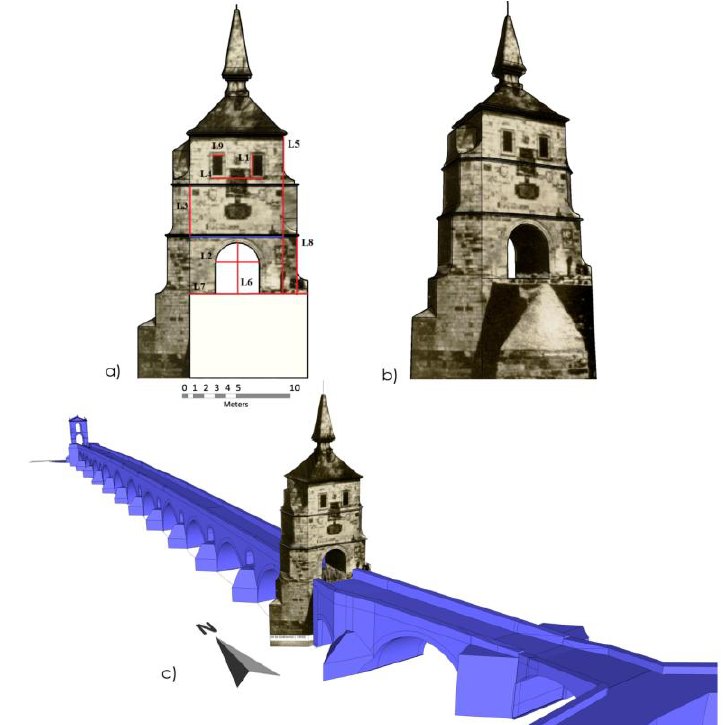
Figure 11. ( a ) Dimensional analysis based on distances for the accuracy assessment; ( b ) Pseudo-3D model of the “Gobierna Tower” obtained through the single image-based modeling approach; ( c ) Virtual 3D reconstruction that integrates the “Gobierna Tower” in the Zamora Stone Bridge.